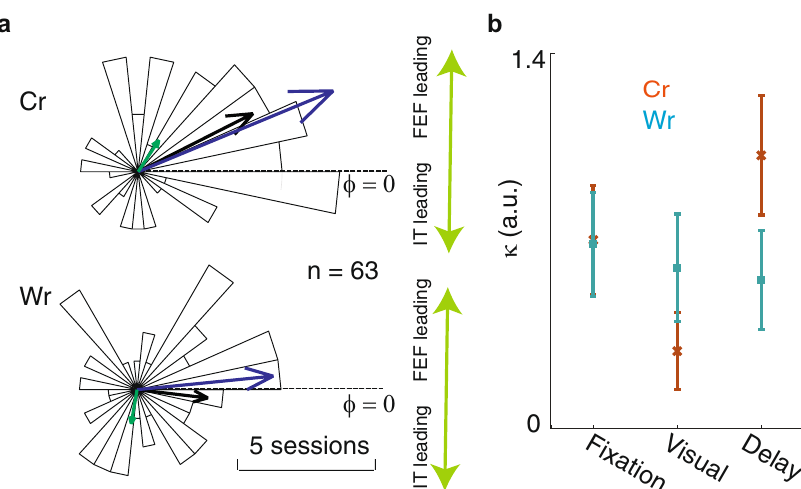
Fig. 3 Inter-areal beta coupling led by FEF. a Beta-band phase differences between areas re fl ected performance. The polar plot shows a histogram of phase differences between the FEF and IT LFPs in the beta band for correct trials (top) and wrong trials (bottom, n = 63 pairs). Arrows show the circular means across all pairs, for M1 (blue), M2 (green), and both (black). b Reliability of phase difference values ( κ ) across sessions (mean ± SD over bootstrap distribution; bootstrap n = 1001) during the fi xation, visual, and delay periods for Cr (brown) and Wr (cyan)